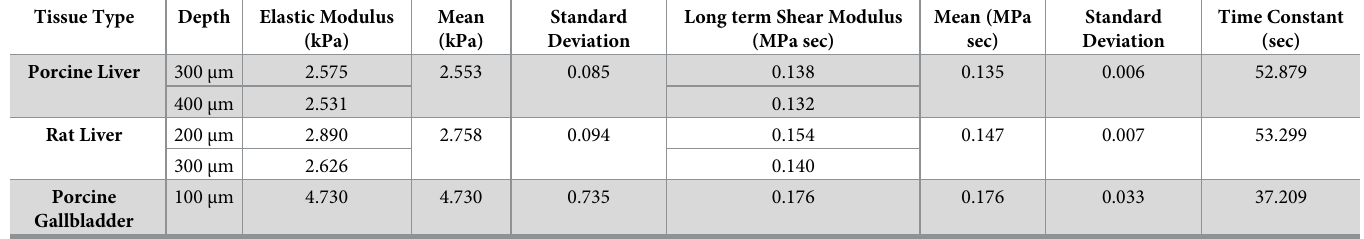
Table 2. Exvivo porcine liver, porcine gallbladder, and rat liver elastic modulus, long term shear modulus, and time constant are calculated. Standard deviation of the mean for each tissue is also computed. Tissue Type Depth